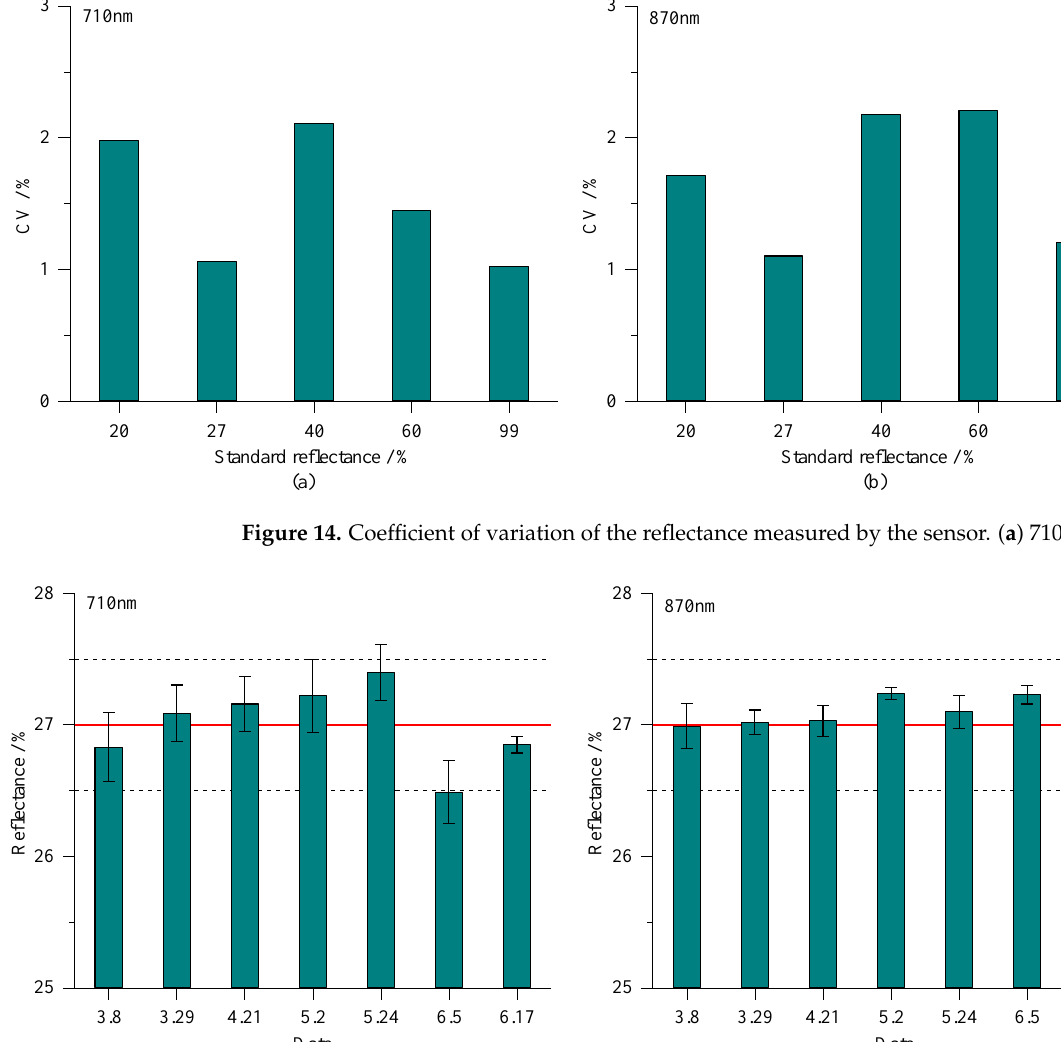
Figure 14. Coefficient of variation of the reflectance measured by the sensor. ( a ) 710 nm; ( b ) 870 nm.